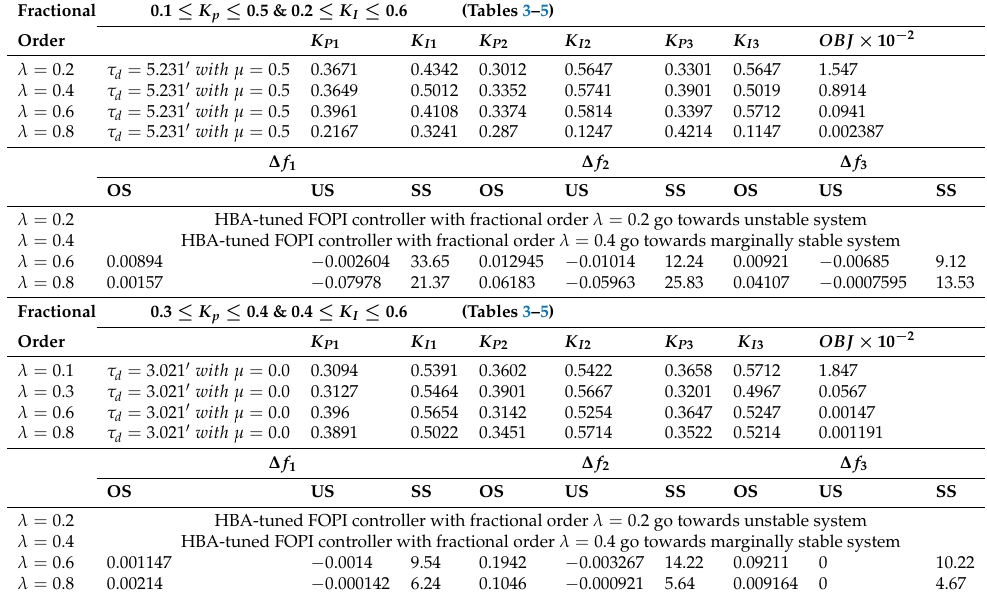
Table 9. Gain values of FOPI controllers for thermal − solar − wind system (test system 2) with DGS system under deregulated environment in contract violation condition with time delays.